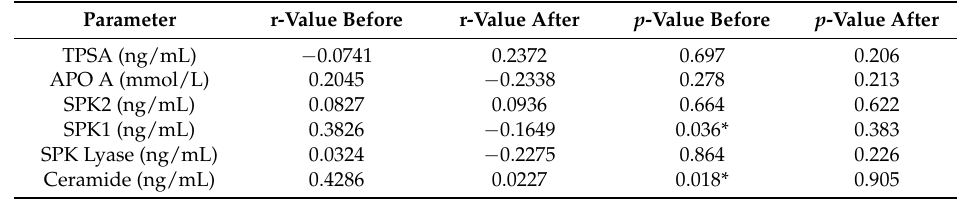
Table 5. A correlation between HDL and the individual analyses.